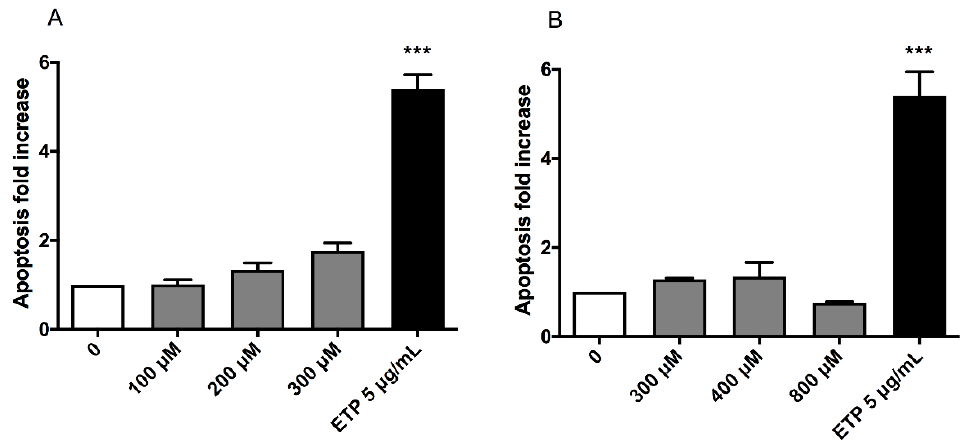
Figure 2. Apoptosis fold increase in TK6 cells after 26 h treatment with ( ± )cis-4,4 (cid:48) -DMAR ( A ), ( ± )trans-4,4 (cid:48) -DMAR ( B ) or the positive control ETP at the indicated concentrations compared to the concurrent negative control [0 µ M]. Each bar represents the mean ± SEM of three independent experiments. Data were analysed using one-way repeated measures ANOVA followed by Bonferroni as post-test. *** p < 0.001 vs. [0 µM].